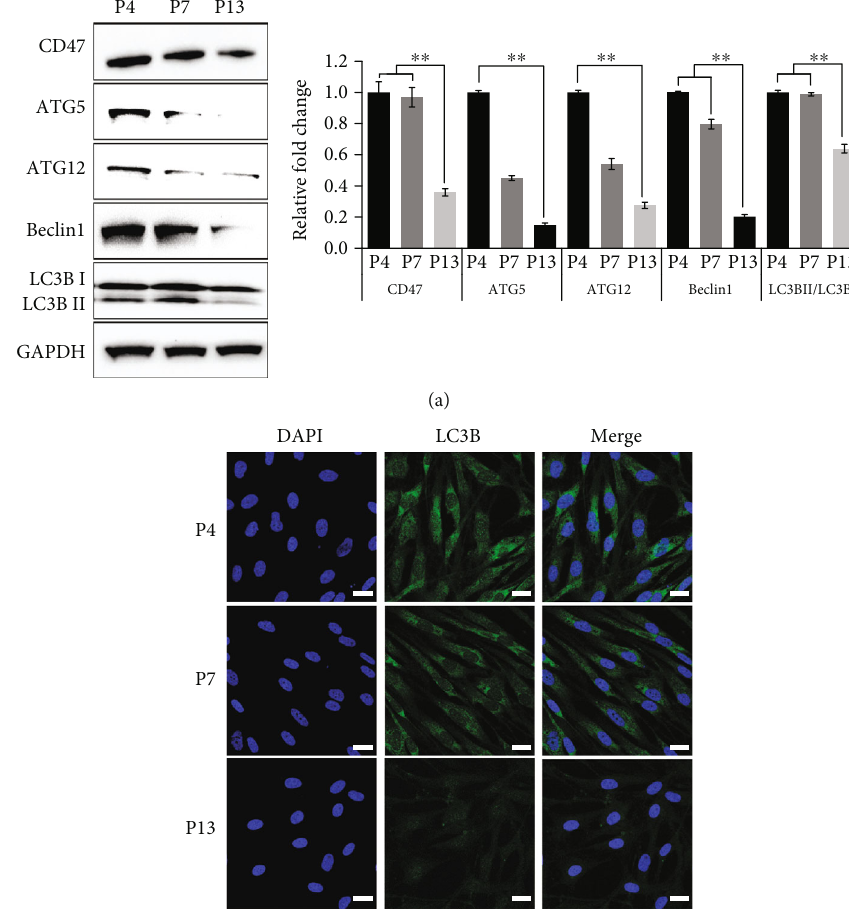
Figure 3: CD47 expressions and autophagy on UCB-MSCs were downregulated during passages. (a) Representative western blot results revealed autophagy-related protein expressions, CD47, ATG5, ATG12, Beclin1, and LC3B during passaging from P4 to P13. Relative fold changes of protein expressions were normalized to each protein level observed at P4. (b) LC3B-positive cells at di ff erent passages (P4, P7, and P13) were monitored by immunostaining. Scale bar 20 μ m. Data is expressed as the mean ± SD ; n = 3 ; ∗∗ p < 0 : 01